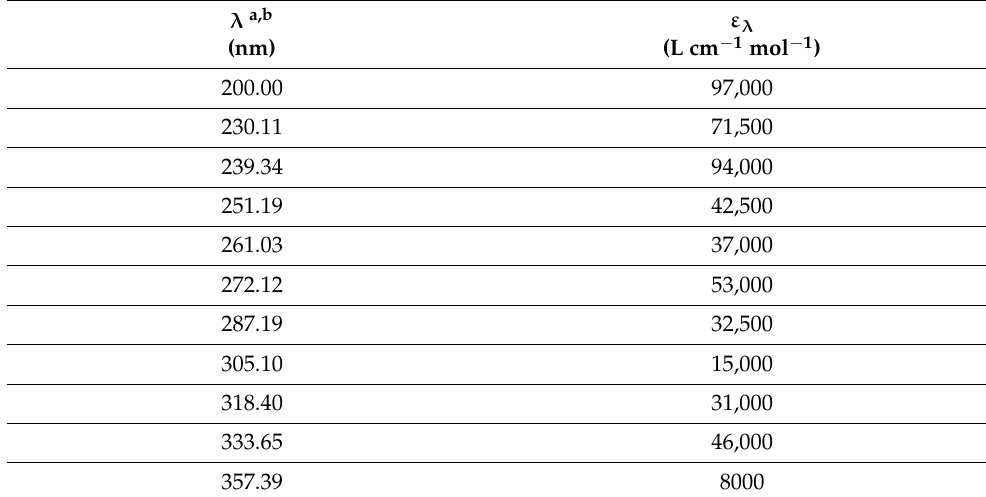
Table 3. The molar extinction coefficients of the UV/VIS bands of C 84 -D 2